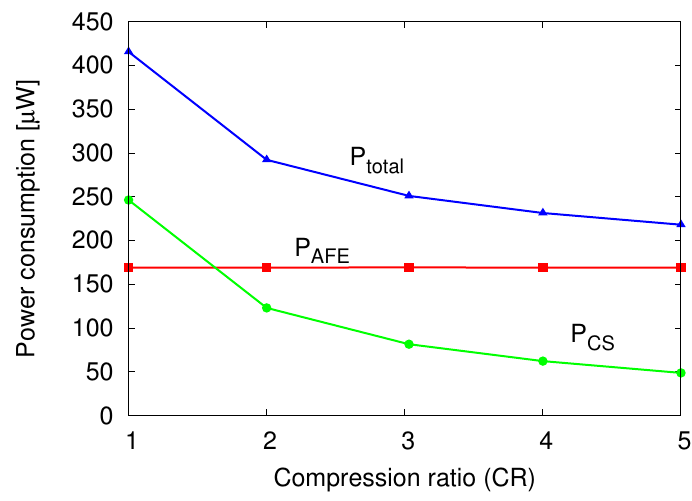
Figure 20. Measured power consumption vs. CR ( f s = 20 ksps).